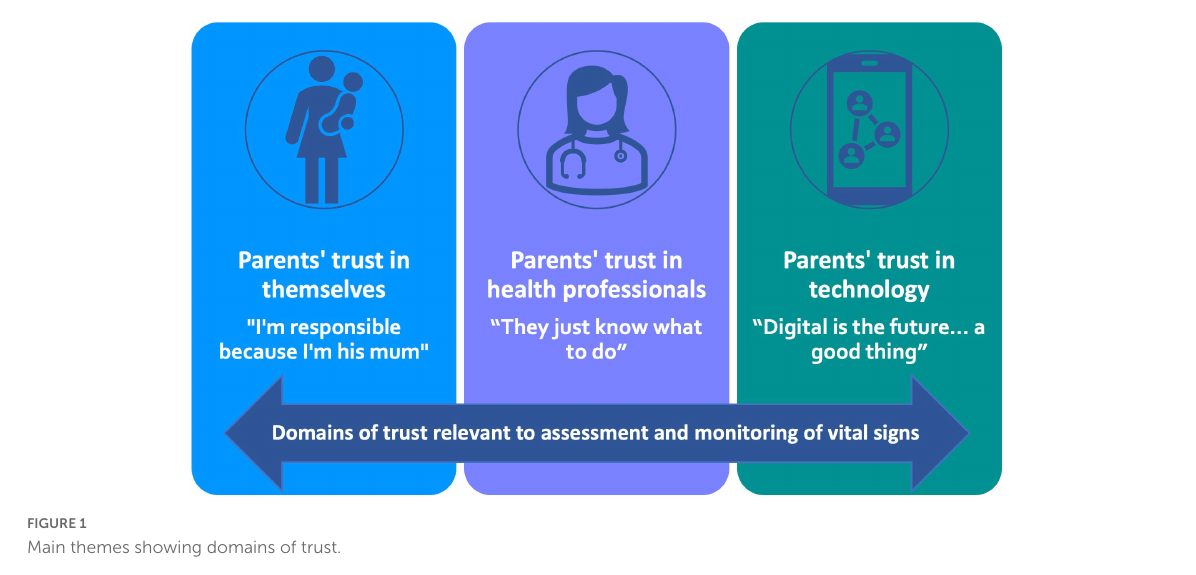
FIGURE1 Main themes showing domains of trust.